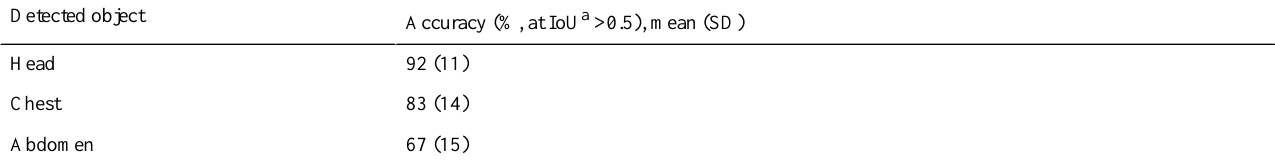
Table 3. Face, chest, and abdomen bounding box.